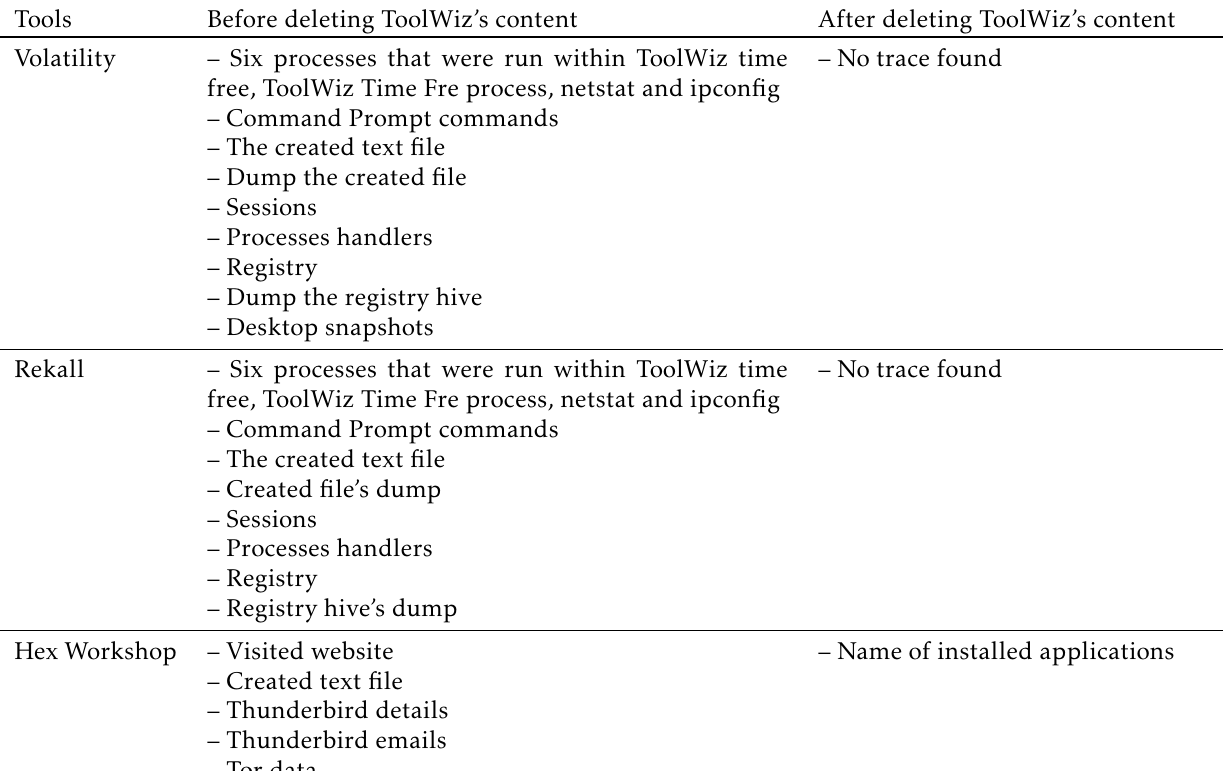
Table 11. Analysis results of the ToolWiz Time Freeze